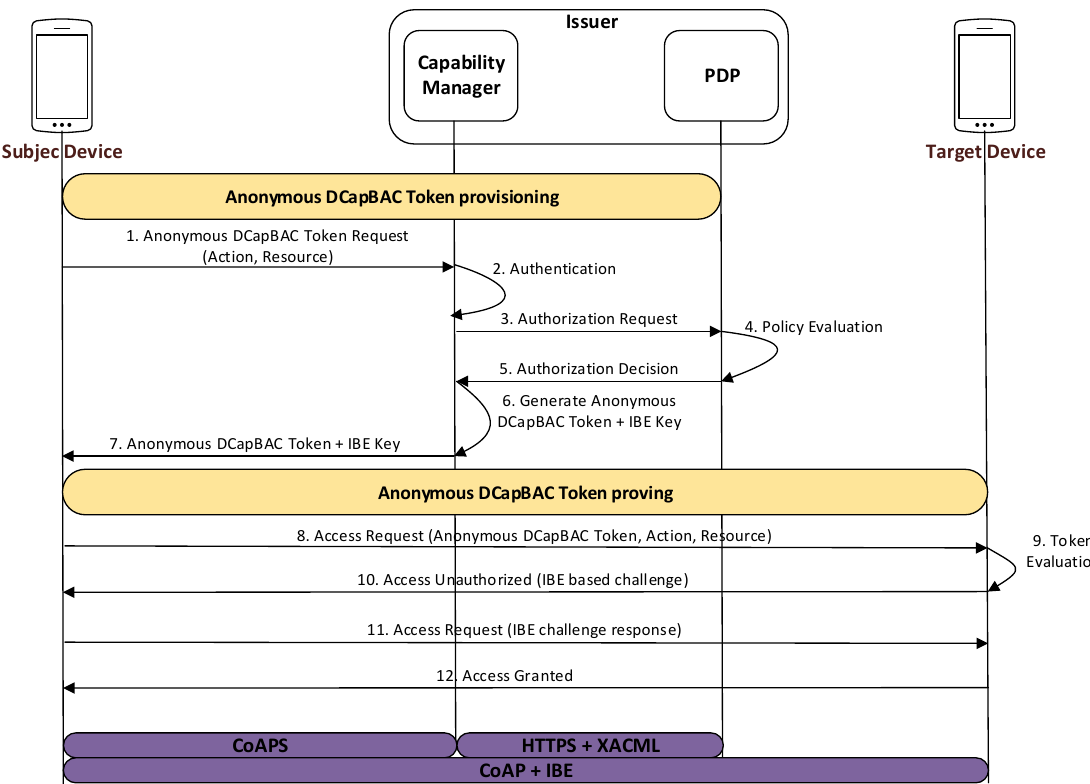
Figure 3. Identity-Based Encryption (IBE)-based Anonymous DCapBAC